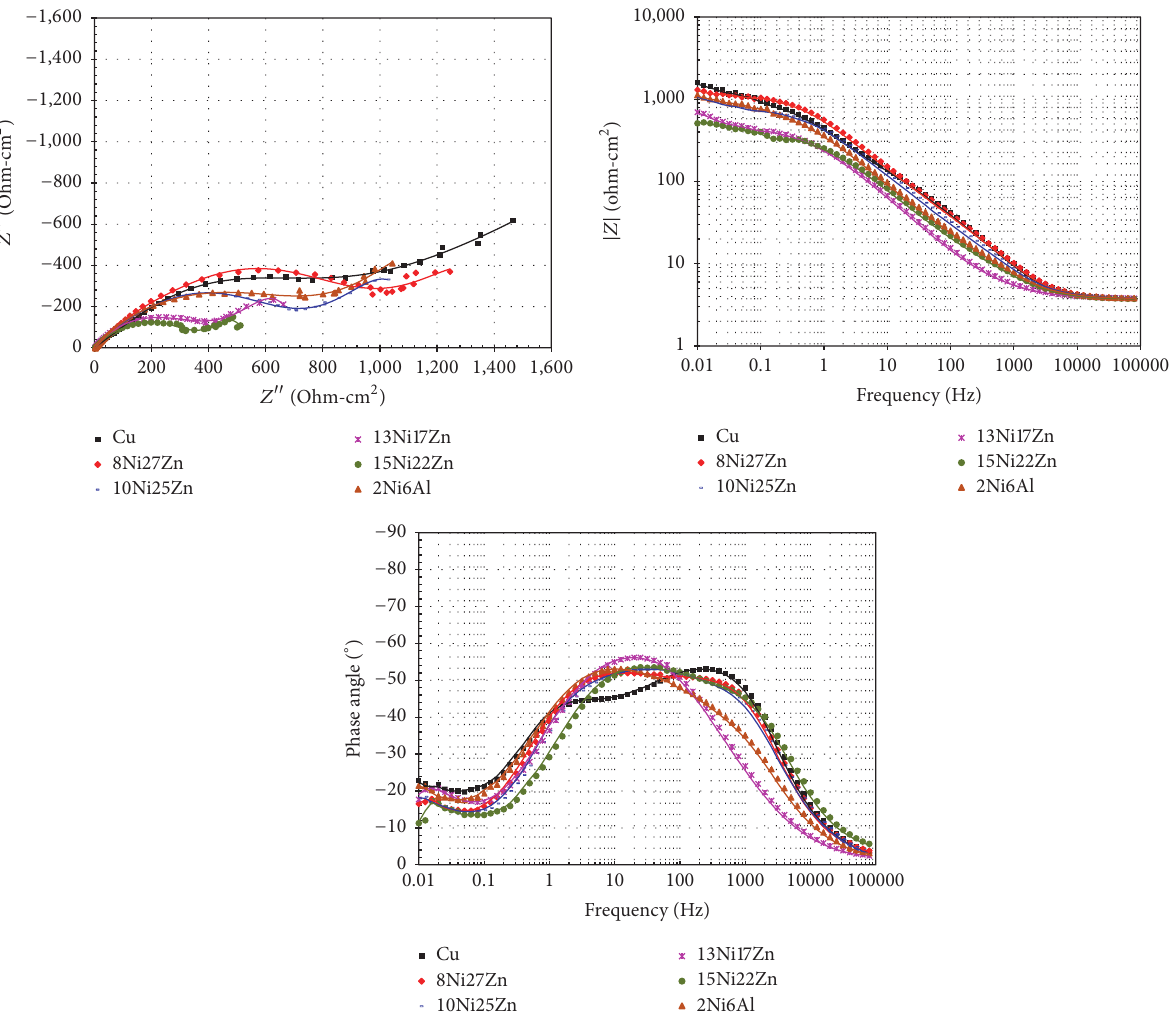
Figure 6: Nyquist and Bode plots for the Cu-based ternary alloys in artificial sweat at 37 ∘ C after 24 hours. Points are the experimental data, and the continuous lines are the fitting